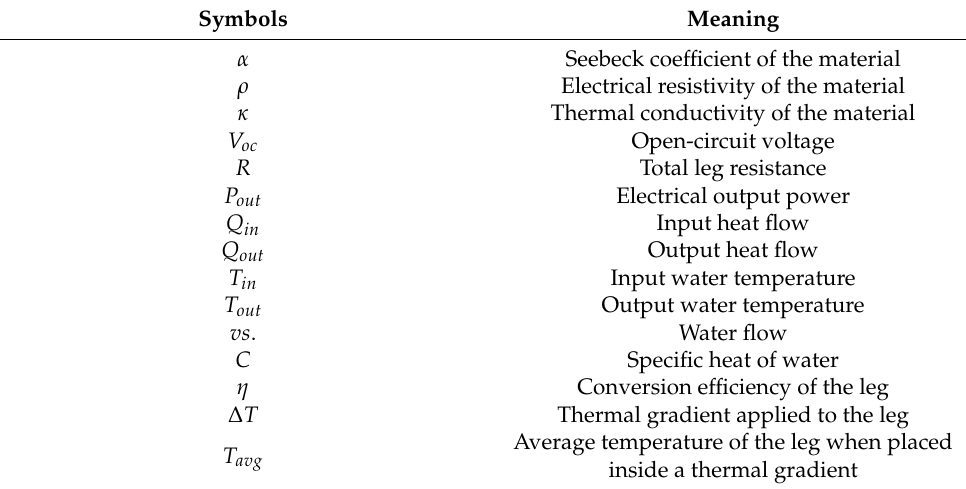
Table A1. Nomenclature of the symbols used in the article.